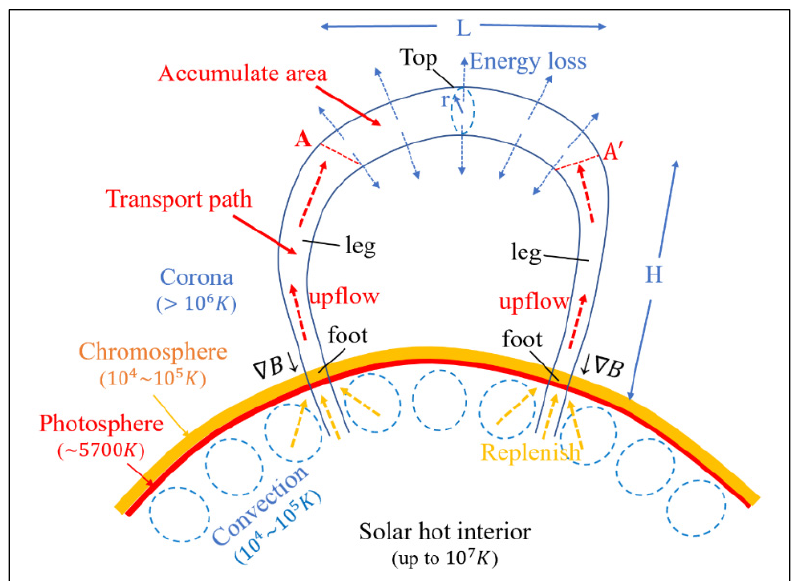
Figure 1. The schematic diagram of a solar magnetized plasma loop. Here, the loop embeds on the photosphere and goes up to the corona and down to the solar hot interior with convection motions. The directions of the magnetic gradients point to downward at both footpoints, which results in the energetic particle flows upward in the legs of the loop. The red dashed lines (A and A’) are the rough boundary between the transport path and the accumulate area.